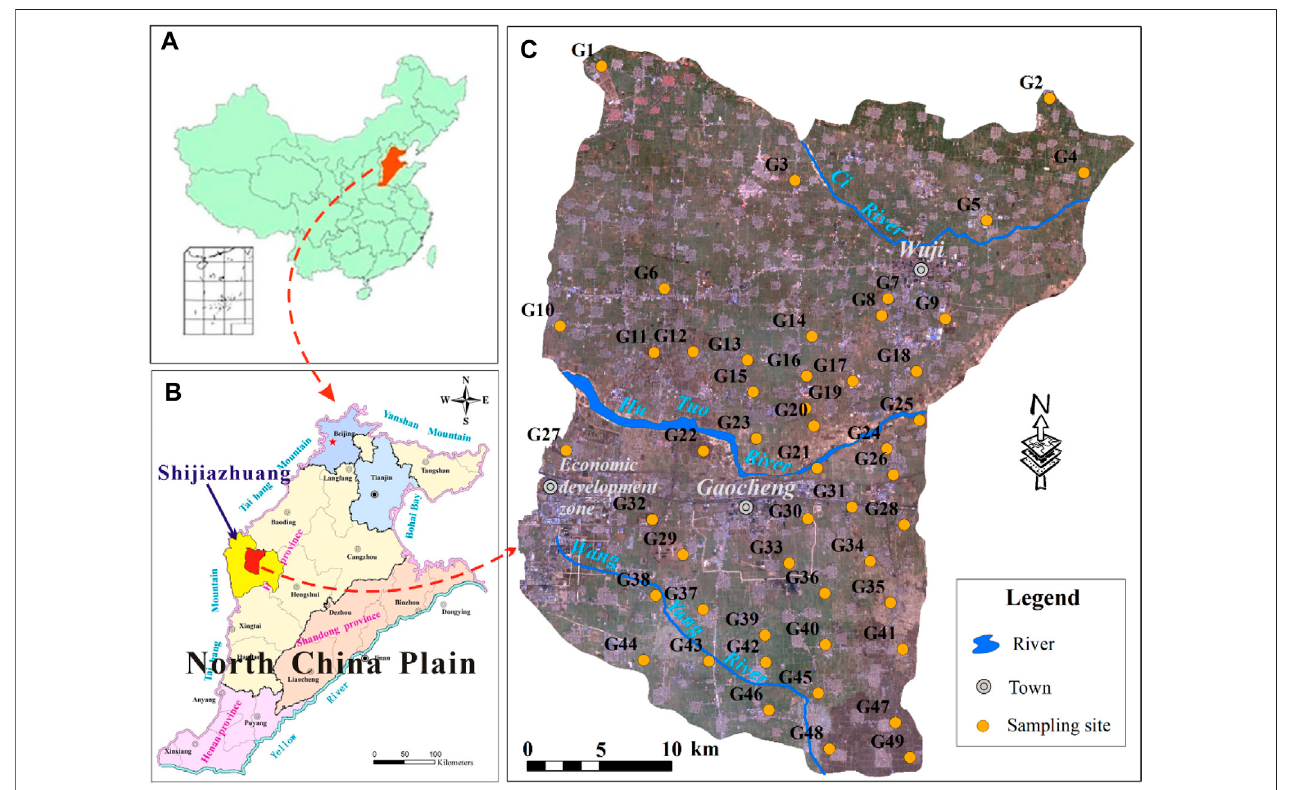
FIGURE 1 | Location of (A) North China Plain, (B) study area, and (C) sampling sites.